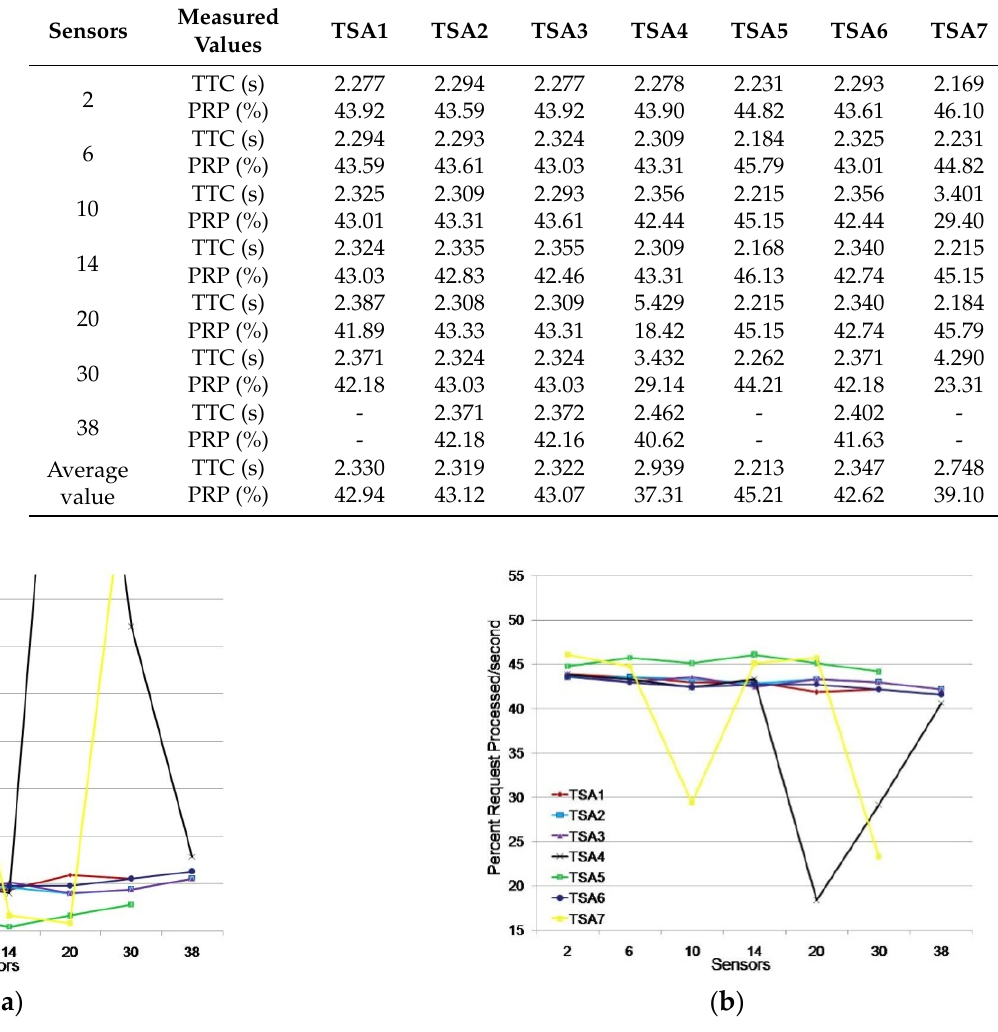
Figure 8. Issuing timestamps for TSAs for an environment with two monitoring applications: ( a ) total time consumed (s); ( b ) percentage of requests processed/s. Table 4. Results of TTC and PRP timestamp issuing of TSAs in an environment with two monitoring applications . Sensors